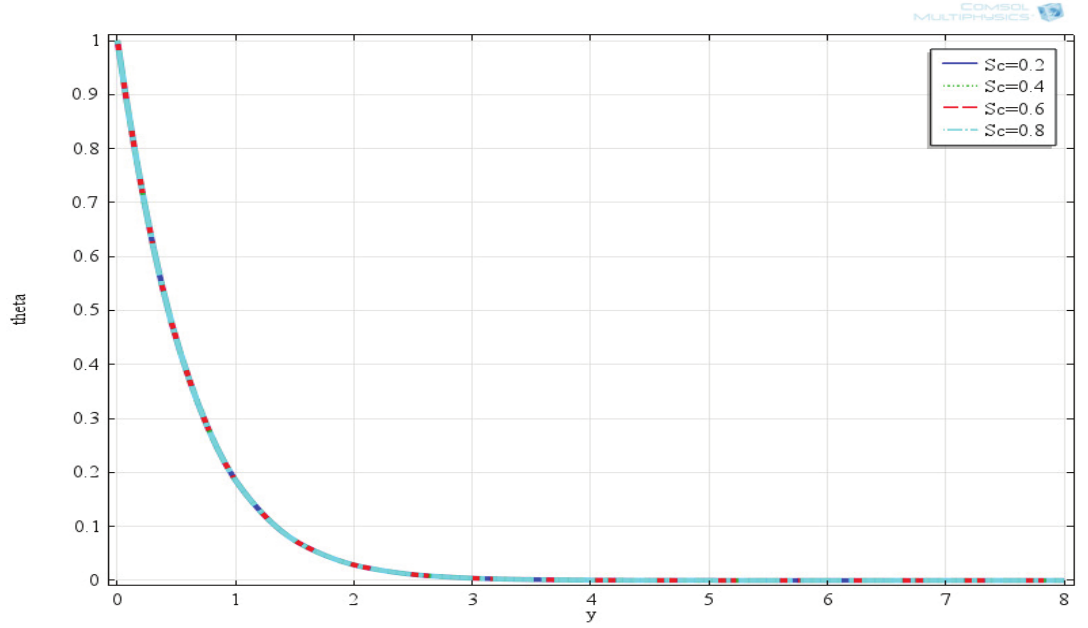
Figure 9: Steady state temperature profiles for different values of Sc at